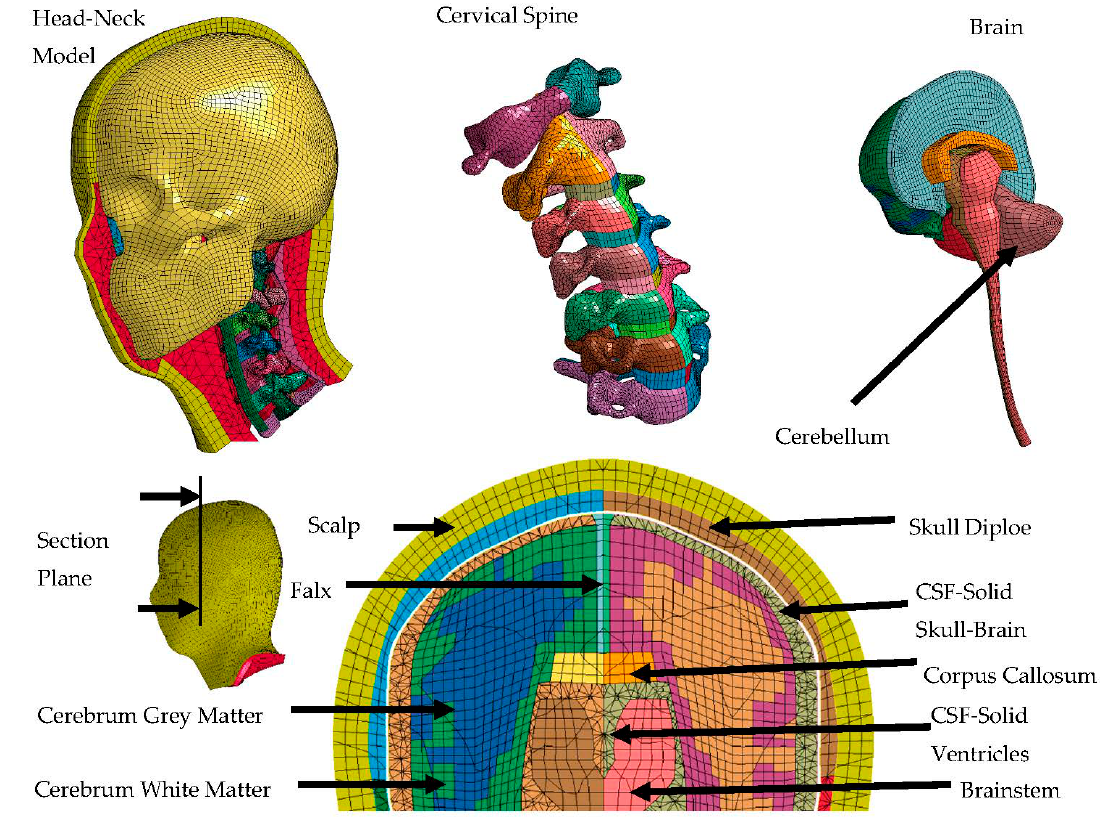
Figure 2. Mesh of partially validated cranio-cervical region.